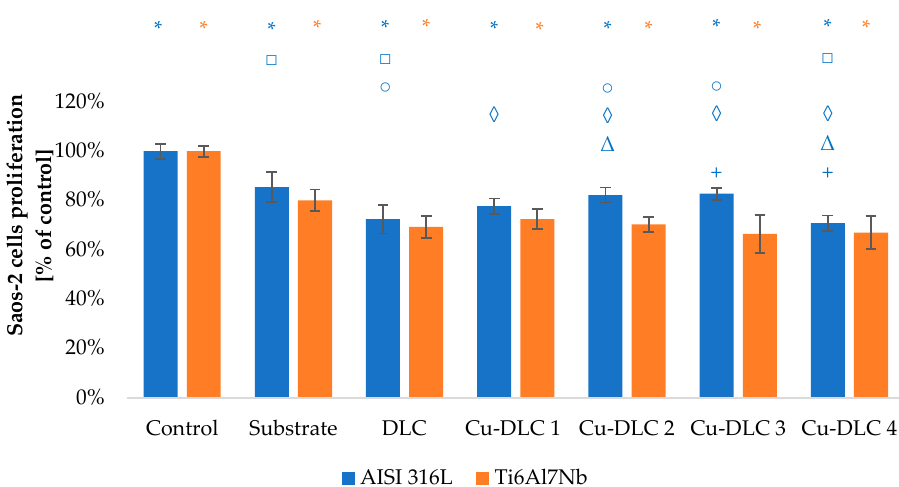
Figure 9. Assessment of proliferation of Saos-2 cells in contact with Ag-DLC coatings. Results of XTT examination.